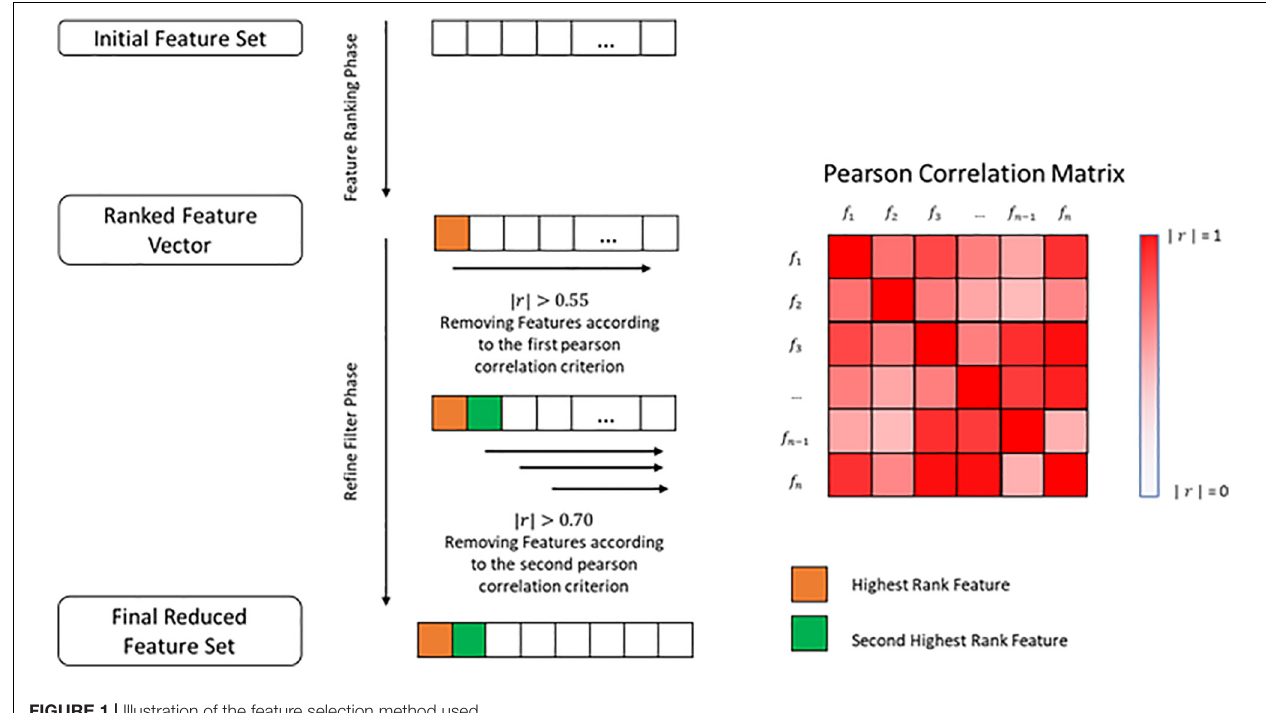
FIGURE 1 | Illustration of the feature selection method used.